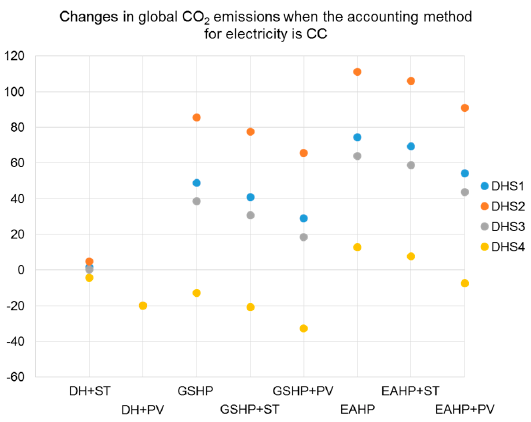
Figure 6. The changes in global CO 2 emissions for different heating sources, and if a ST or a PV system is used, compared to if the building is heated with DH only. The four different compositions of DHS presented in Table 4 are compared and the allocation for changes in electricity use/production is CC. The yellow DHS 4 marking for DH+PV represents all four systems.